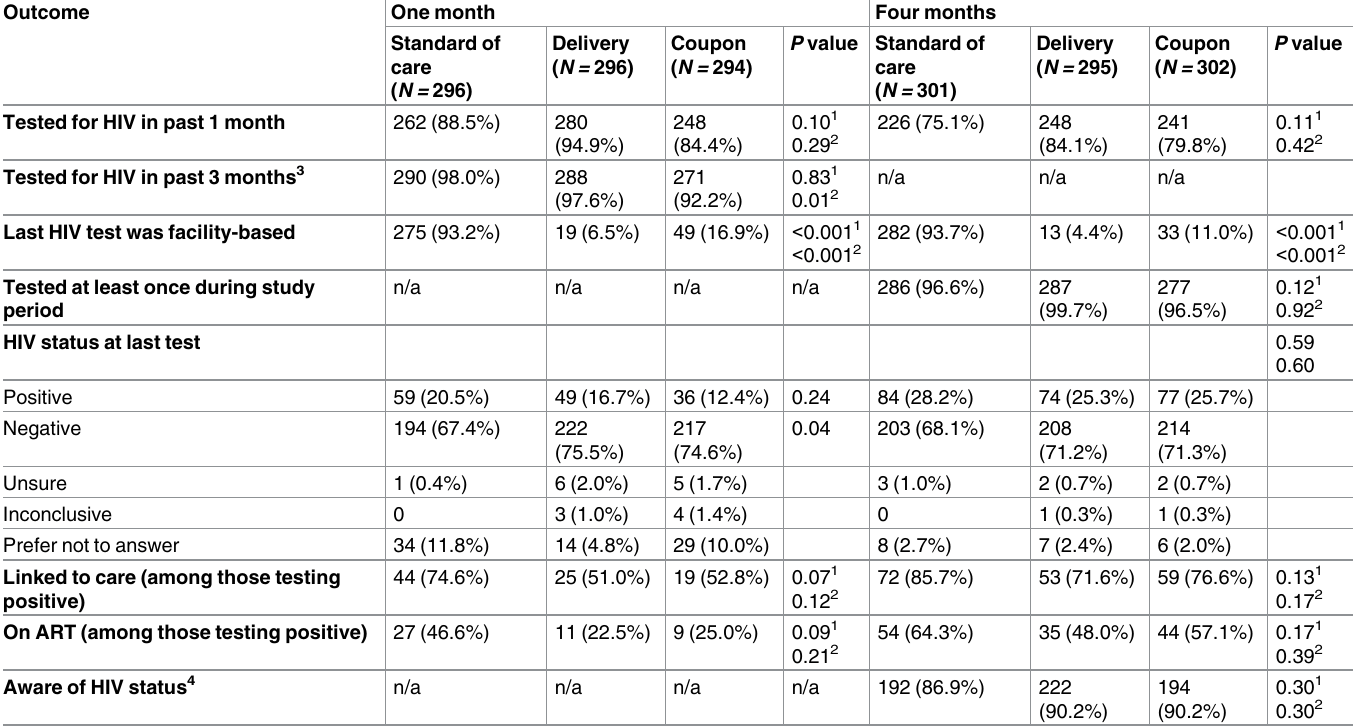
Table 2. HIV testing and linkage to care at 1 and 4 months by study